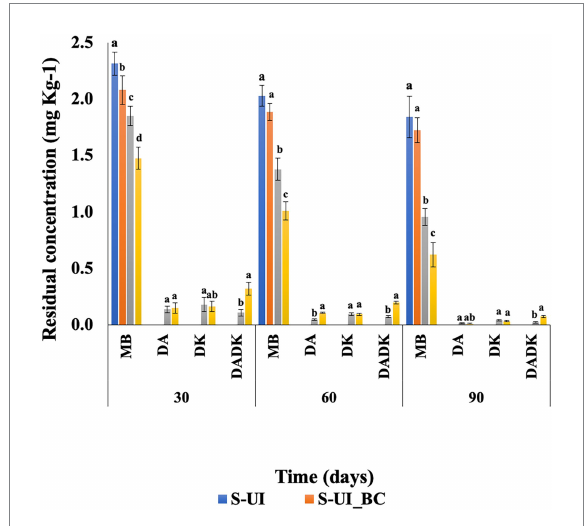
FIGURE 3 Beta-diversity analysis of soil microbial communities under various treatments by using principal component analysis (PCA) based on Operational Taxonomic Units